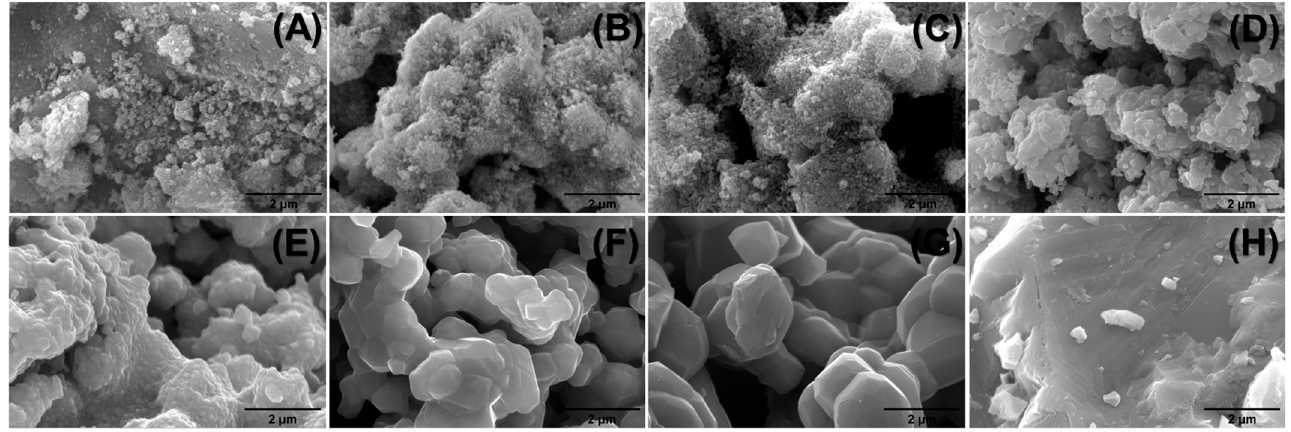
Figure 5. The micrographs of CuFe 2 O 4 : ( A ) 400, ( B ) 500, ( C ) 600, ( D ) 700, ( E ) 800, ( F ) 900, ( G ) 1000, and ( H ) 1100 °C.